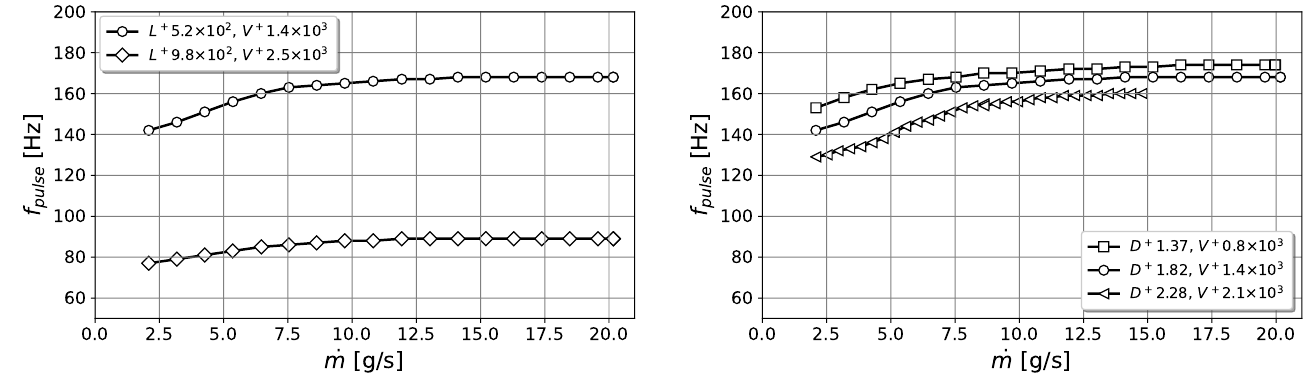
Figure 13. Variation of feedback loop length ( left ) and feedback loop diameter ( right ) using the reference geometry with a constant throttling ratio of T OP =